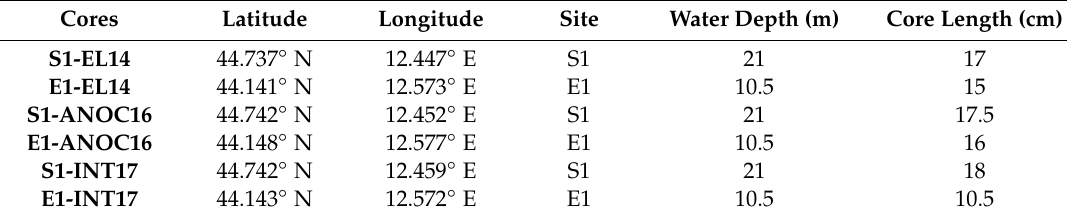
Table 1. Details of sampling